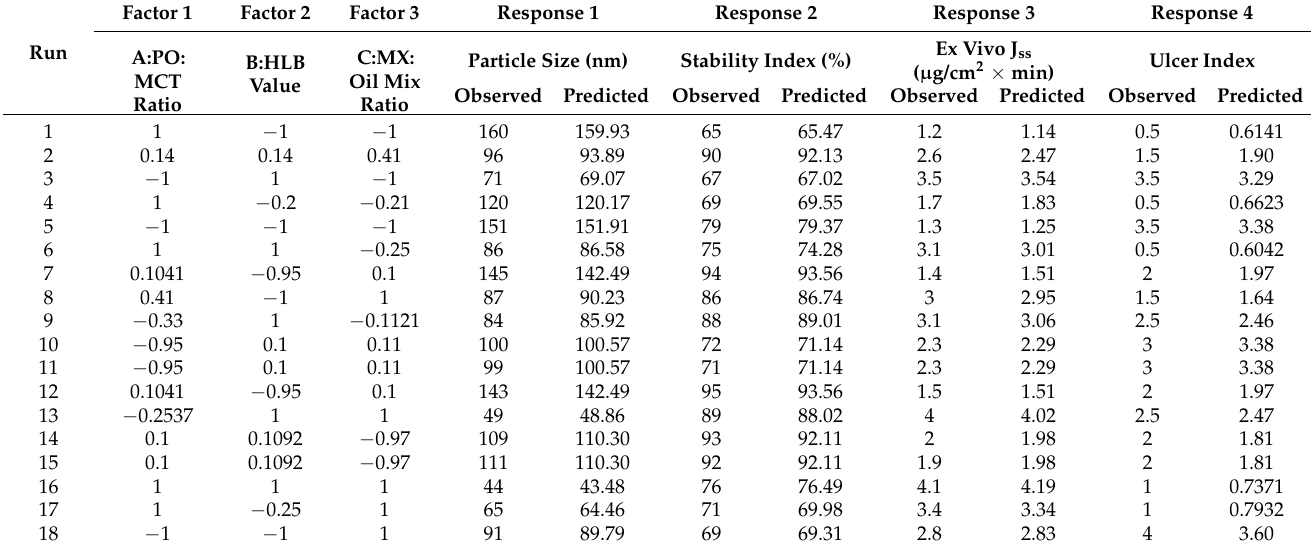
Table 4. The independent factors and responses for the design of experiments.